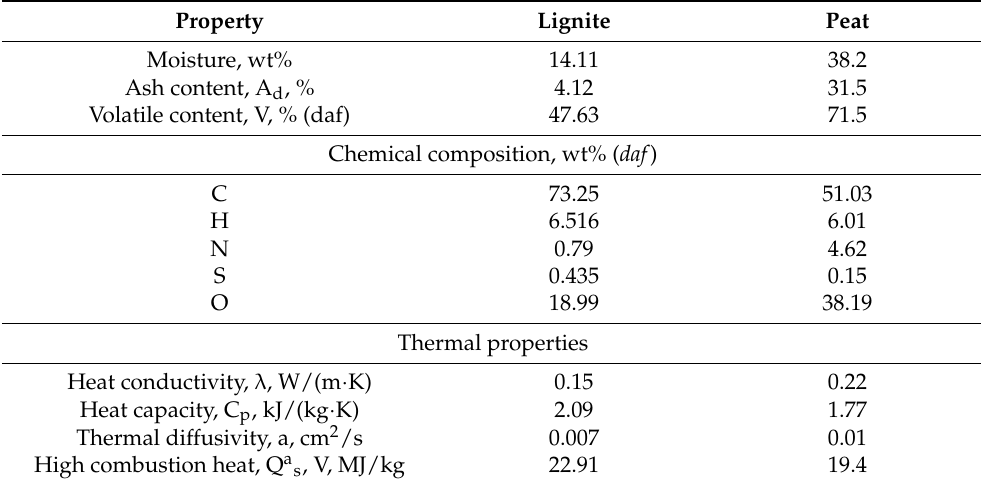
Table 1. Properties of solid components of the fuel composition